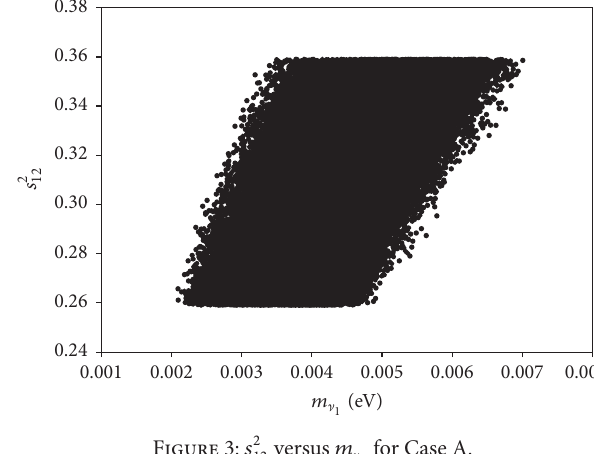
Figure 3: 𝑠 2 12 versus 𝑚 ]